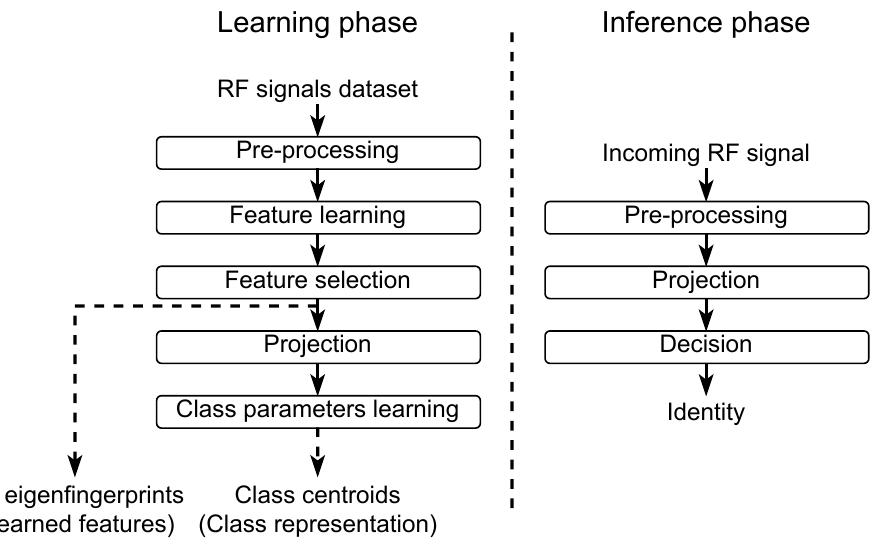
Figure 2. Methodology